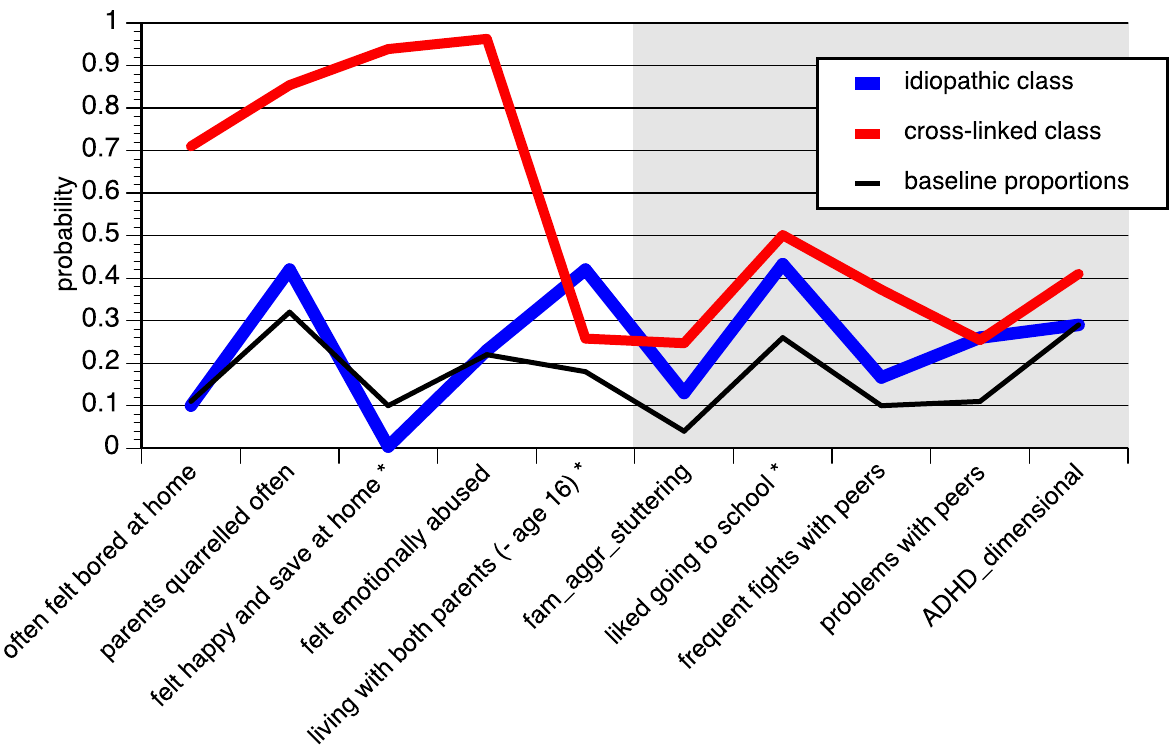
Fig 1. Probabilities of the two class LCA of stuttering and baseline proportions of risk / associated factors in the ZInEP study. Items with asterisks were reversed. The grey area denotes items whose probabilities were assigned post hoc to the latent classes. The items were grouped and their probabilities were connected by lines in order to facilitate examination of the